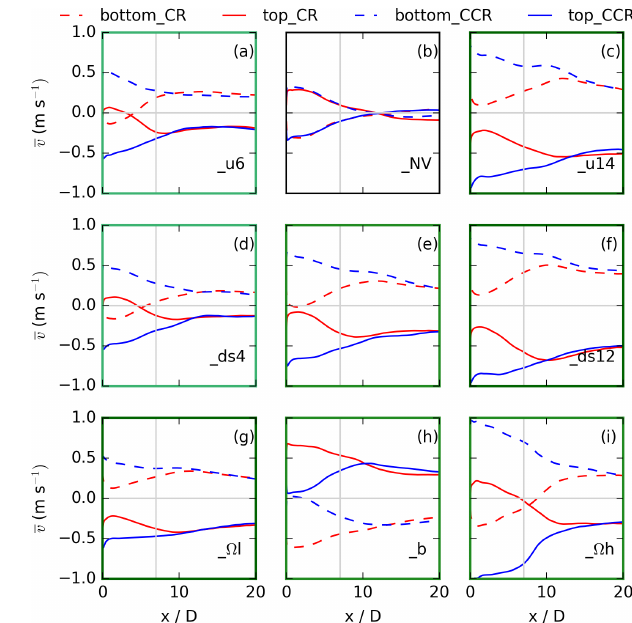
Figure 18. Sector averages of v representing the top and bottom 90 ◦ sectors for 0m <r ≤ 50m for clockwise- and counterclockwise-rotating actuators in the corresponding simula- tion of no veer in (b) , a veering wind in (e) , and a backing wind in (h) . In the case of a veering wind in (e) , moderate parame- ters of u g = 10ms − 1 , ds = 0.08 ◦ m − 1 , and (cid:127) = 0.12 ◦ s − 1 are ap- plied. In the left (a, d, g) and right (c, f, i) column, only one pa- rameter is changed compared to the veering-wind situation in (e)